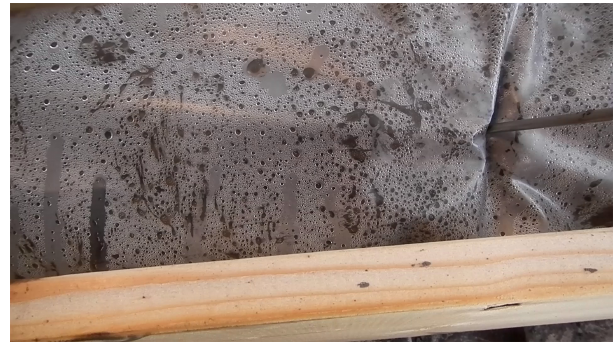
Figure 7. Vapour condensation on the inside of plastic sampling sleeve at ground surface. Core temperature at ground surface was 85 ◦ C.